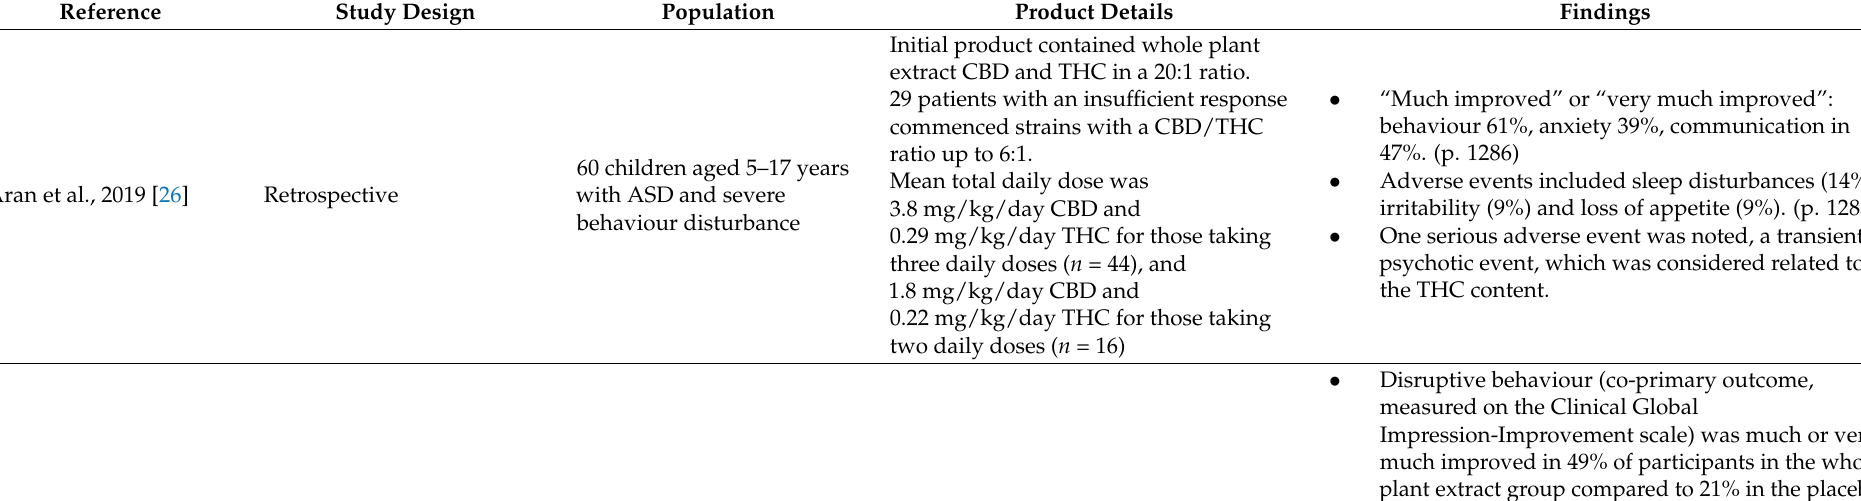
Table 1. Published studies of medicinal cannabis in autism spectrum